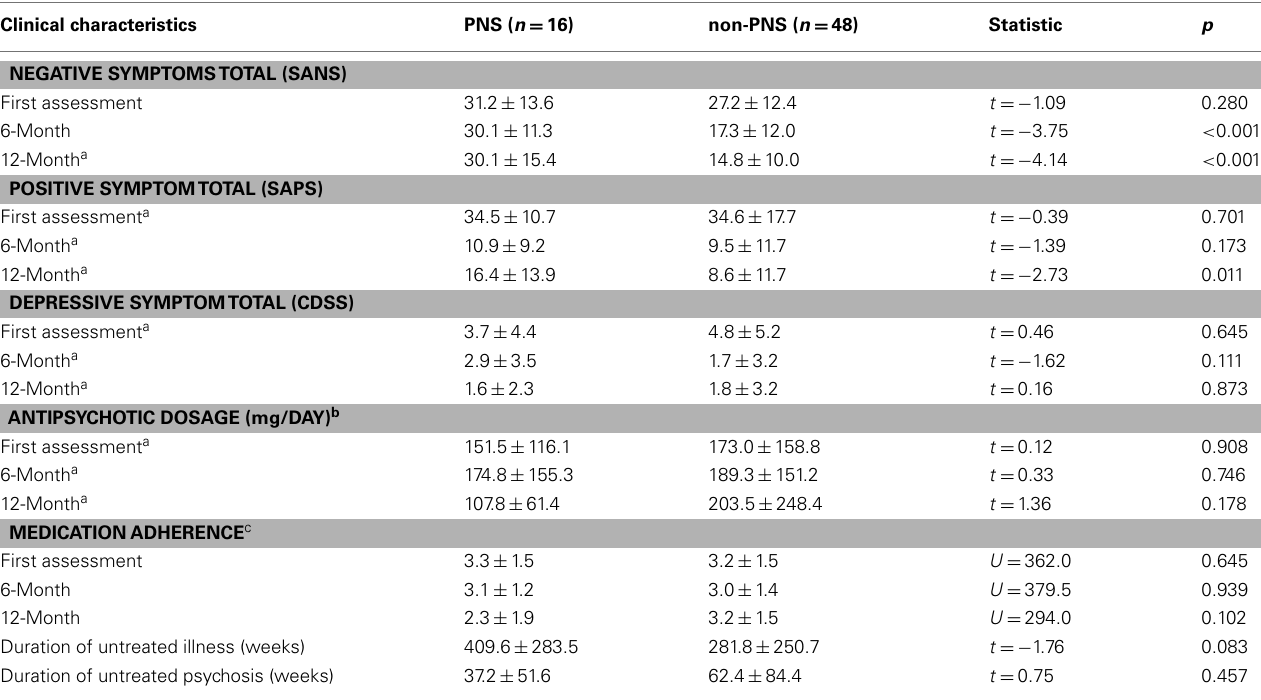
Table 3 | Clinical characteristics for PNS and non-PNS